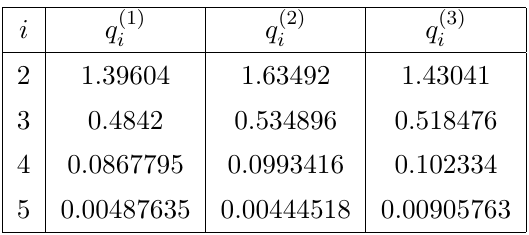
for eq. (B.8) and eq. (B.11). j